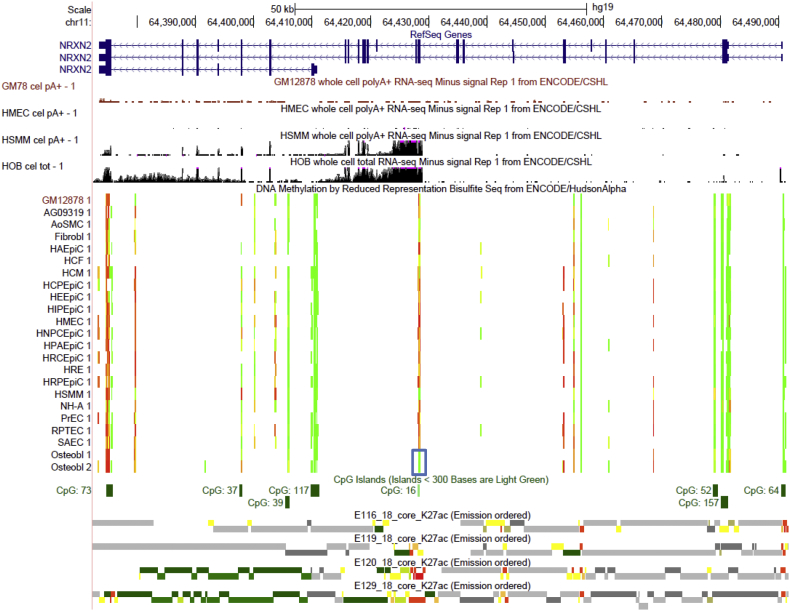
Osteoblastic hypomethylation at NRXN2 gene region. The same tracks as illustrated in Fig. 3 are shown using the UCSC Genome Browser (http://genome.ucsc.edu, version hg19). Osteoblast-specific DMR is highlighted in the blue box.